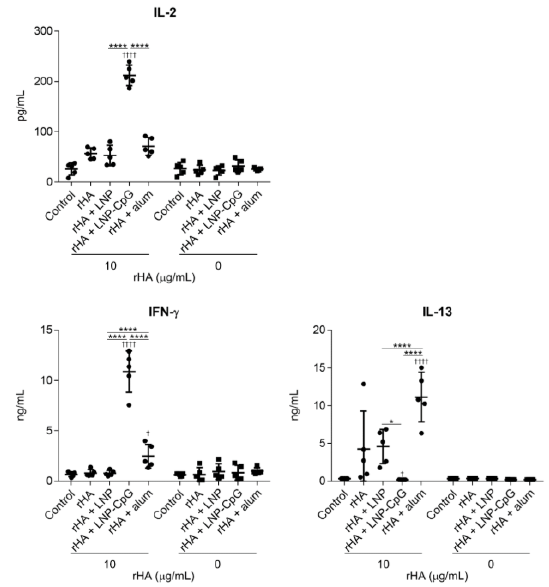
Figure 7. HA-specific T-cell responses in vivo. Mice were subcutaneously immunized with rHA alone, rHA plus LNP, rHA plus LNP-CpG, or rHA plus alum on days 0 and 21. On day 28, splenocytes were cultured in the presence or absence of rHA in vitro. After 1 (for IL-2) or 5 (for IFN- γ and IL-13) days, the levels of IL-2, IFN- γ , and IL-13 were measured by using ELISA. n = 5 per group. Data are means ± SD. † p < 0.05 and †††† p < 0.0001 vs. group immunized with rHA alone; * p < 0.05, **** p < 0.0001, as indicated by Tukey’s test.